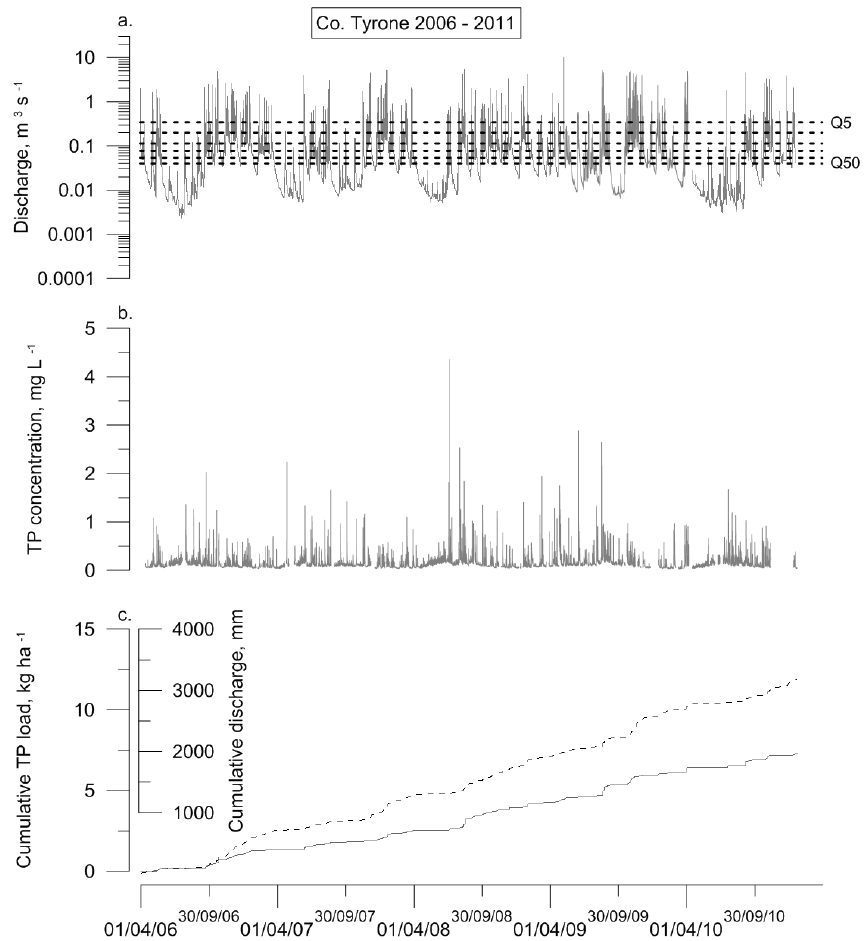
Figure 4. Time-series charts for discharge (a) , TP concentration (b) and cumulative TP load and cumulative discharge (solid line) (c) from 2006–2011 in the Co. Tyrone sub-catchment. Discharge ranges ( Q 50 , Q 40 , Q 30 , Q 20 , Q 10 and Q 5 ) are shown on the discharge time series as dashed lines.